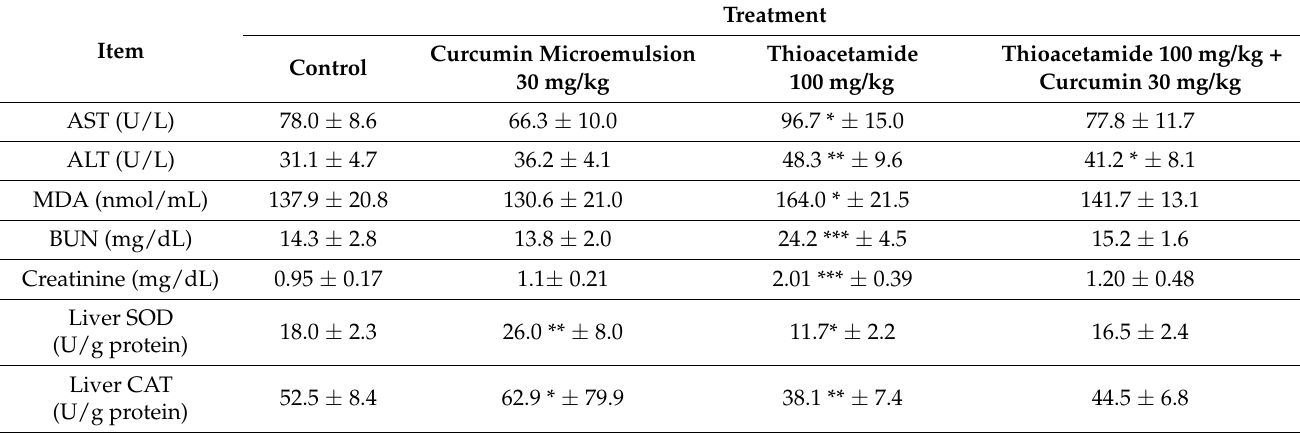
Table 1. Serum biochemical parameters and lipid peroxidation in rats. *, ** and *** indicate a statistically significant difference with p < 0.05, p < 0.01, and p < 0.001, respectively, for the control